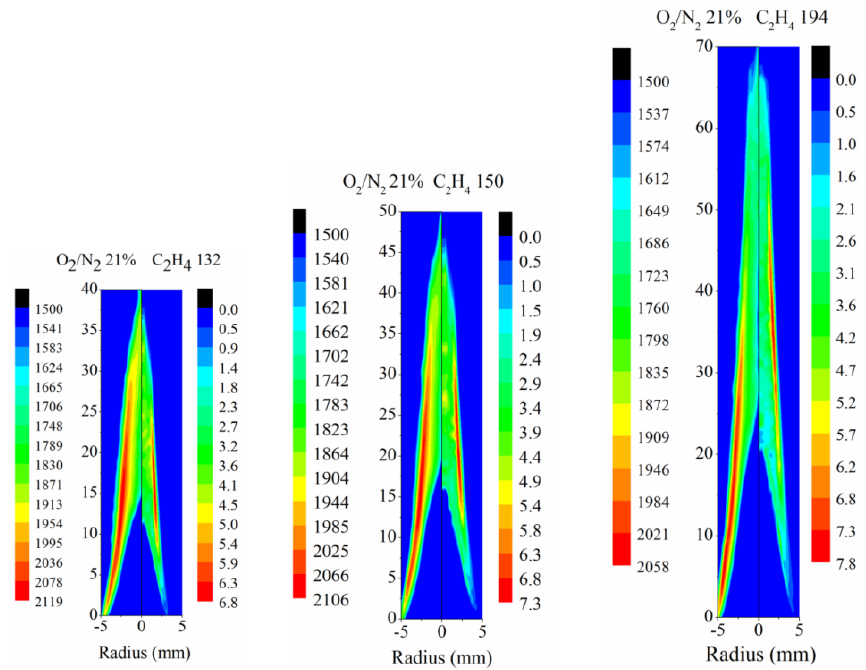
Figure 15. 2-D distributions of temperature T (K) and soot volume fraction (10 − 6 ) for C 2 H 4 combustion in pure air atmospheres. Table 2. Maximum temperatures and soot volume fractions of the nine cases.